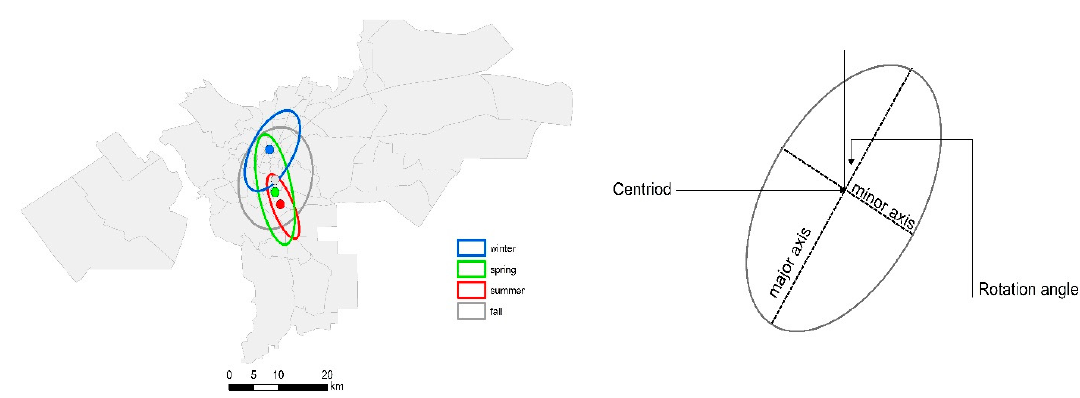
Figure 8. Standard deviational ellipses (SDEs) of the spatial coverage of the most anomalous hotspot over Greater Cairo for the period 2003–2019. SDEs were computed using one standard deviation. The colored circles in the left panel refer to the centroid of hotspot for each season. The right panel indicates the different elements of SED. Table 1. The main statistics of the Standard Deviational Ellipse (SDE) method for the most anomalous hot and cold spot domains. The Most Anomalous Hotspot The Most Anomalous Cold Spot Indicator